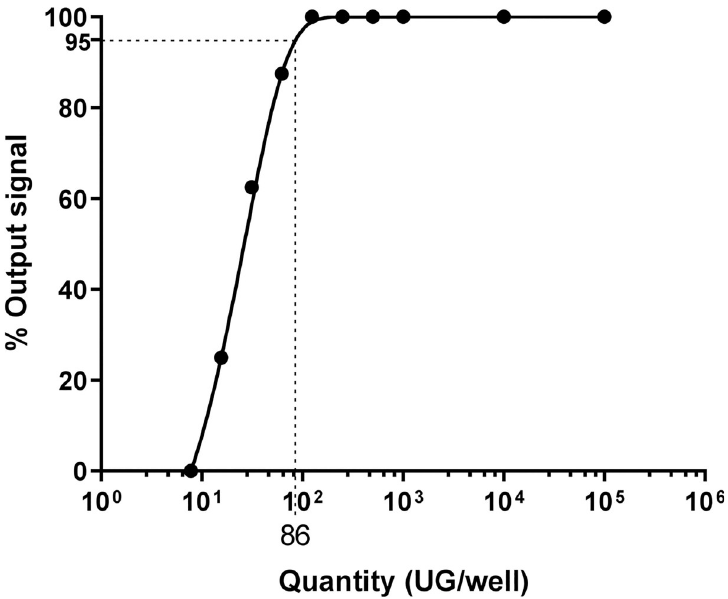
Fig 3. Determination by PMAqPCR of LoD for the LipL32 gene using serial dilution (eight replicates for each dilution).